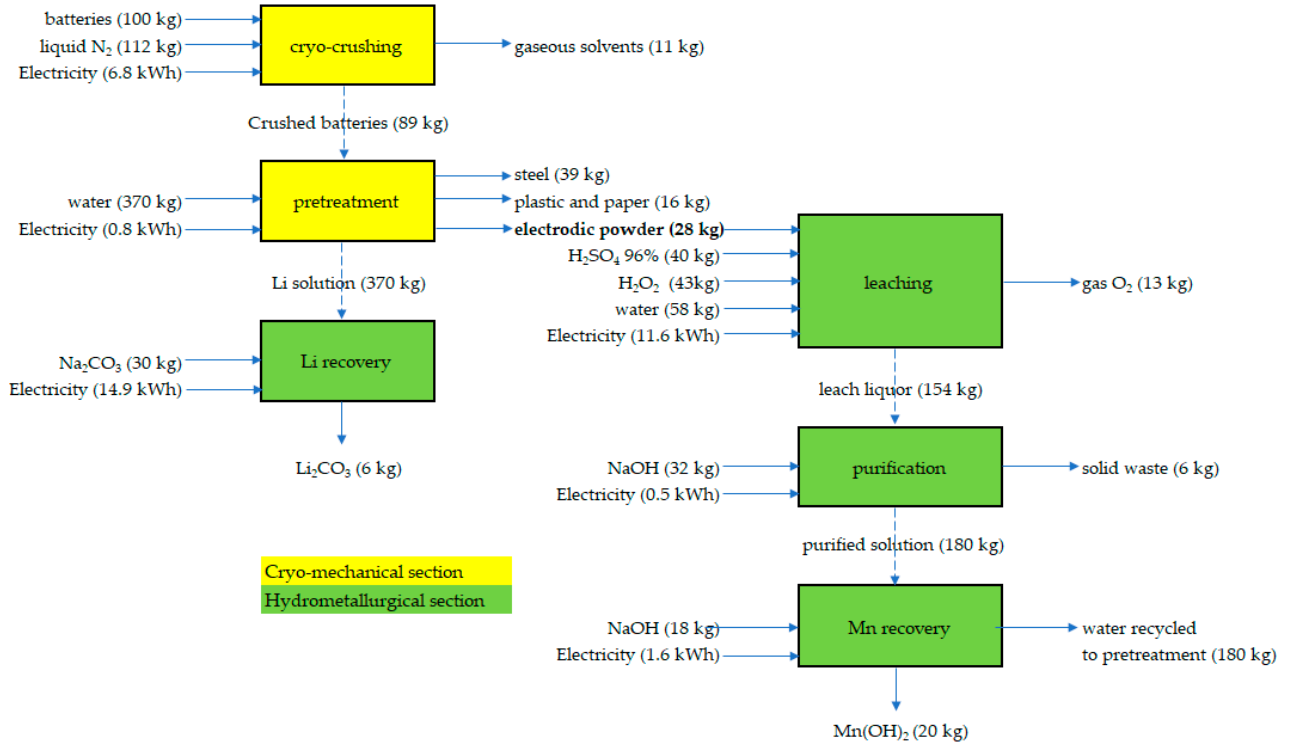
Figure 1. Process flow diagram for the cryomechanical and hydrometallurgical sections of the process for Li(0) recycling. for Li(0)